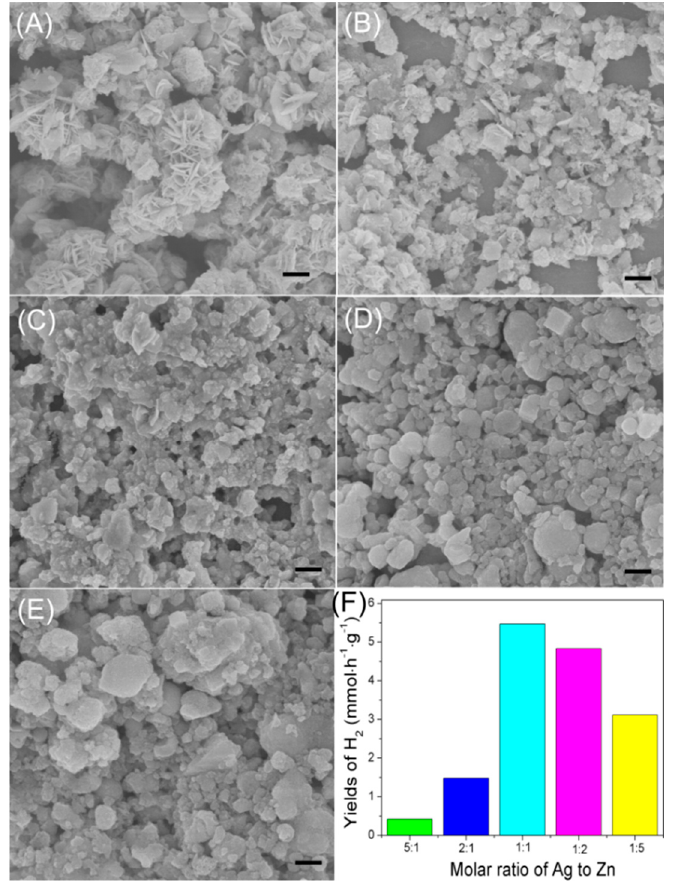
Figure 2. SEM images of AgInS 2 - x Ag 2 S- y ZnS- z In 6 S 7 composite nanoparticles with different molar ratios of Ag:Zn ( A ) 5:1; ( B ) 2:1; ( C ) 1:1; ( D ) 1:2; ( E ) 1:5 (The scale bars are all 400 nm); and a corresponding comparison chart of the photocatalytic H 2 production in a reaction period of 12 h ( F ).